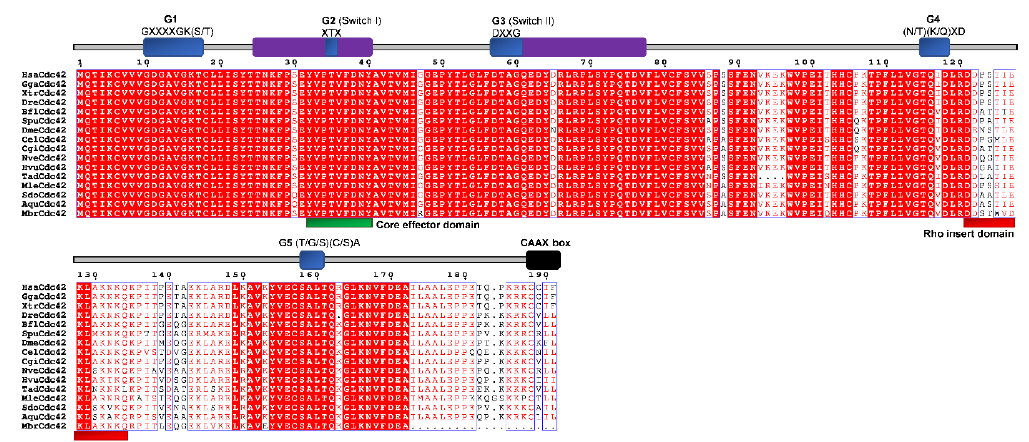
Figure 6. Sequence alignment of the Cdc42 subfamily. The amino acid sequences of Cdc42 GTPases were aligned using ClustalX, the secondary structures predicted using ESPript. Regions of the Cdc42 proteins are indicated above the alignment; blue are the G domains, (G1, G2, G3, G4, and G5 with their respected motifs), purple are switch 1 and switch 2 domains, red is the Rho insert, green is the polybasic region, and black is the CAAX box. Blue frames are indicators of the conserved residues; white letters in red boxes represent identity, red letters in white boxes represent similarity.